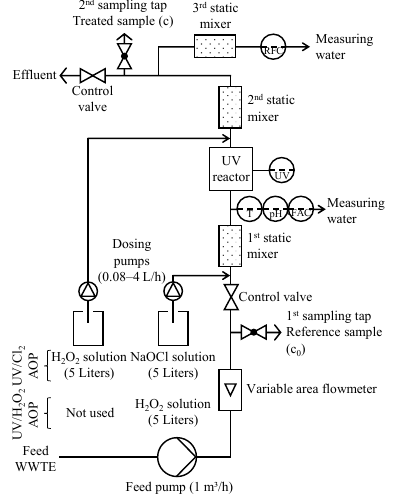
Figure 2. Technical scheme of the UV/chlorine AOP and UV/H 2 O 2 AOP pilot plant used in the experiments. Figure 2. TechnicalschemeoftheUV/chlorineAOPandUV/H 2 O 2